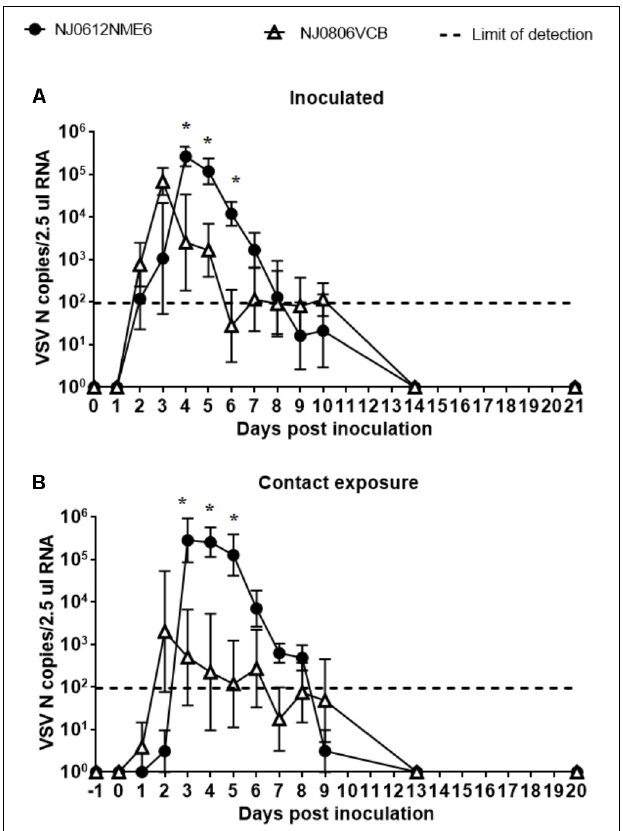
FIGURE 10 | RNAemia. VSNJV RNA in blood was detected in (A) inoculated and (B) contact exposure pigs. Dashed lines represent the limit of detection of rRT-PCR (1.98 VSV N copies/2.5 µ l RNA). Values represent means and standard deviations for each group, and significantly different values ( p < 0.05) between groups are indicated with asterisks ( ∗